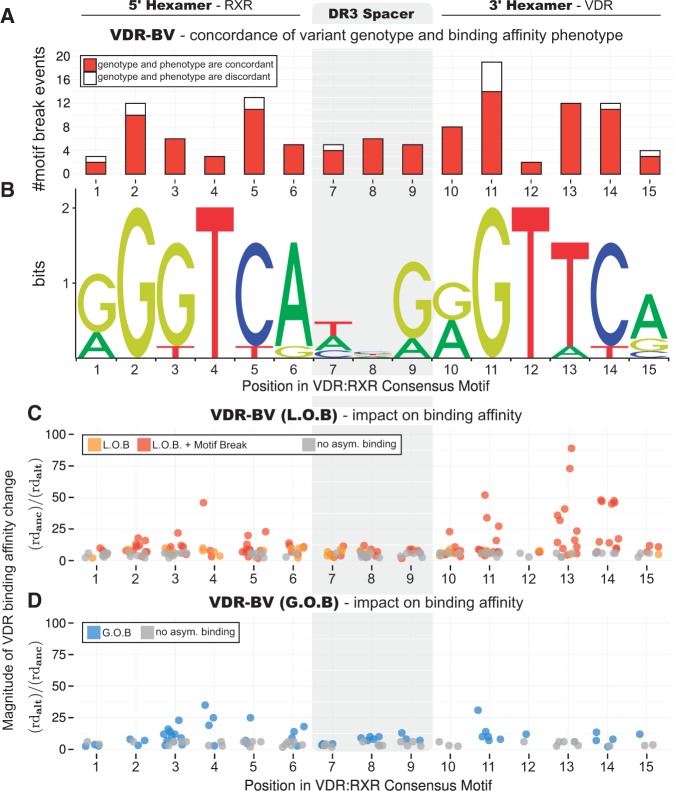
Genetic variation modulating VDR binding affinity in LCLs within the canonical RXR::VDR heterodimeric binding motif. The figure shows a genome-wide quantification of the effect of genetic variation on VDR binding, based on the analysis of VDR-BVs in CPo3 binding peaks which hit the canonical RXR::VDR DR3 heterodimeric consensus motif (motif shown in B, JASPAR database, (19)). (A) Distribution across the RXR::VDR motif of VDR-BVs which cause significant motif disruption (significance assessed via FunSeq2 using TFMPvalue (82), with default threshold P<4 × 10−8) and quantification of the concordance between directionality of VDR PWM disruption and directionality of resulting VDR binding affinity variation. 102/115 (89%) VDR-BVs in CPo3 VDR peaks that significantly break the RXR::VDR motif predict the direction of VDR binding affinity change. (C,D) Genome-wide quantification of the phenotypic effect of all VDR-BVs intersecting the RXR::VDR motif (including those which do not generate a motif break at the above significance level). The vertical axis (Magnitude of VDR binding affinity change) indicates the fold change of read depth of the ancestral versus the derived allele (C) or derived versus the ancestral allele (D). (C) Impact on VDR binding affinity of Loss of Binding (LOB, orange dots) VDR-BVs and Loss of Binding VDR-BVs which test for significant RXR::VDR motif break (red dots). (D) Impact on VDR binding affinity of Gain of Binding (GOB) VDR-BVs (blue dots). Nucleotide position has a significant influence on LOB (Kruskal-Wallis rank sum test, x2(14) = 33.385, P<0.01 ) but not on GOB (x2(12) = 17.68, P=.12) phenotype magnitude. (C,D) Grey dots indicate impact on binding affinity of those 1000 Genomes variants carried by the LCL samples which do not test for significant asymmetric binding (AlleleSeq (23), FDR threshold = 0.1) and are not, therefore, VDR-BVs.